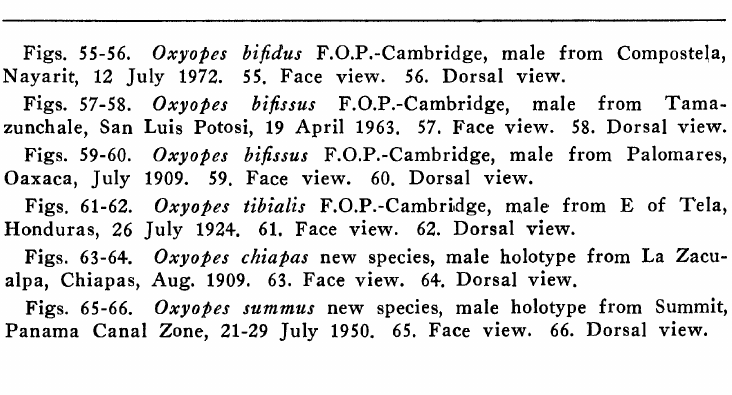
Figs. 55-56. Oxy’opes bifidus F.O.P.-Cambridge, male from Composte!a, Nayarit, 12 July 1972. 55. Face view. 56. Dorsal view. Figs. 57-58. Oxyopes bifissus F.O.P.-Cambridge, male from Tama- zunchale, San Luis Potosi, 19 April 1963. 57. Face view. 58. Dorsal view. Figs. 59-60. Oxyopes bifissus F.O.P.-Cambridge, male from Palomares, Oaxaca, July 1909. 59. Face view. 60. Dorsal view. Figs. 61-62. Oxyopes tibialis F.O.P.-Cambri,dge, male from E of Tela, Honduras, 26 July 1924. 61. Face view. 62. Dorsal view. Figs. 63-64. Oxyopes chiapas new species, male holotype from La Zacu- alpa, Chiapas, Aug. 1909. 63. Face view. 64. Dorsal view. Figs. 65-66. Oxyopes summus new species, male holotype from Summit, Panama Canal Zone, 21-29 July 1950. 65. Face view. 66. Dorsal